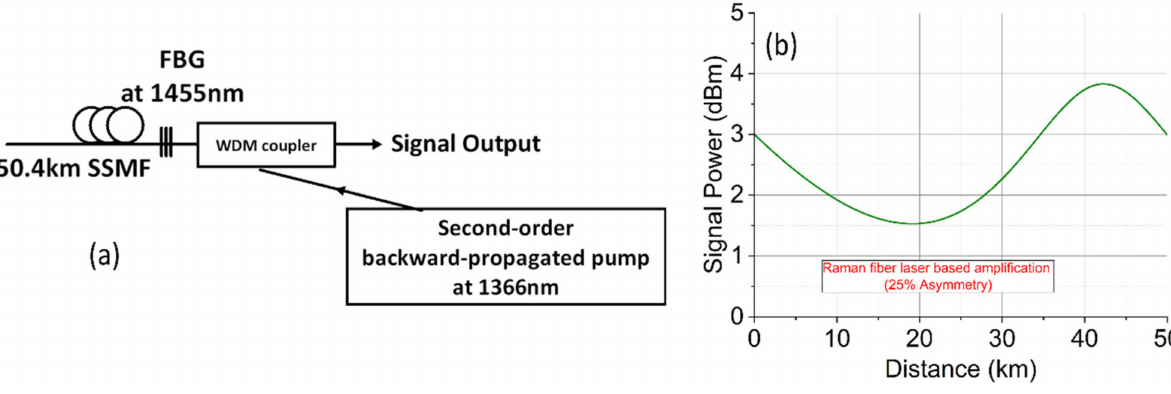
Figure 3. ( a ) Raman-fiber-laser-based amplification with second-order pumping; ( b ) simulated signal power